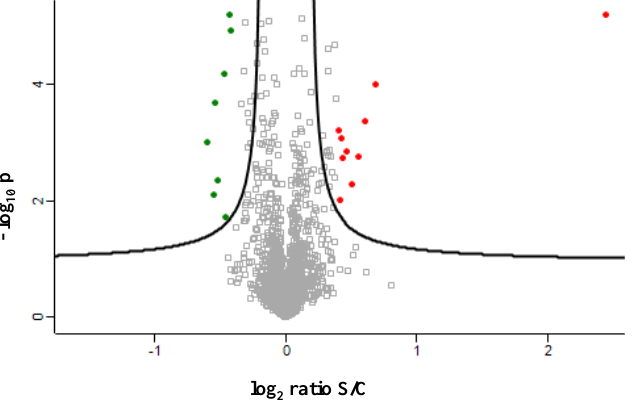
Figure 4. Differentially regulated proteins in NAFLD (S), compared with control (C) resulted from SILAC analysis. Two biological and three technical Figure 4. A) Differentially regulated proteins in NAFLD ( S ), compared with control ( C ) resulted from SILAC analysis. Two biological and technical triplicates.